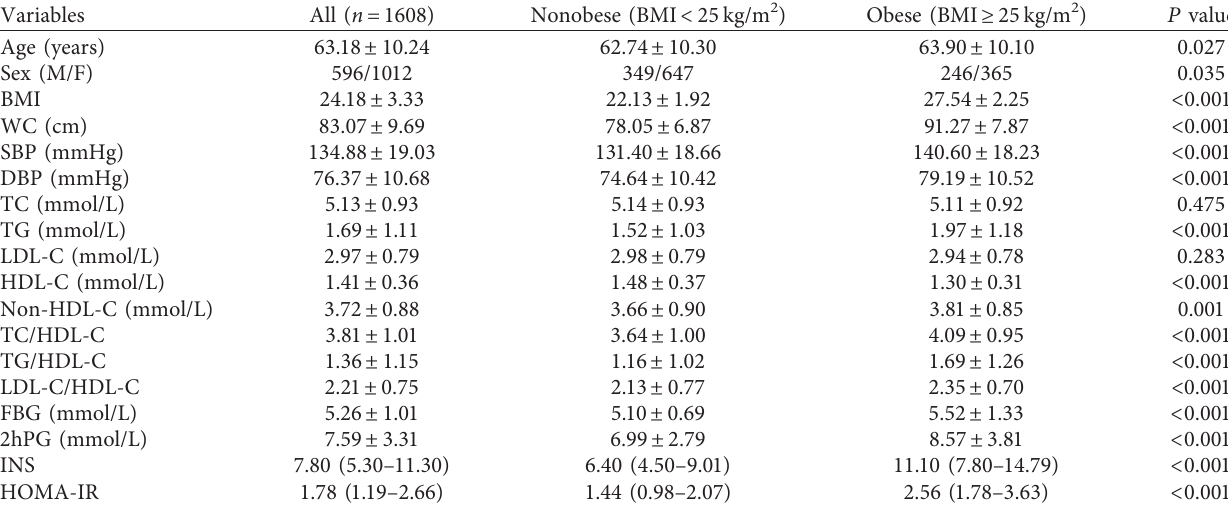
Table 1: Clinical and biochemical characteristics of the study subjects according to